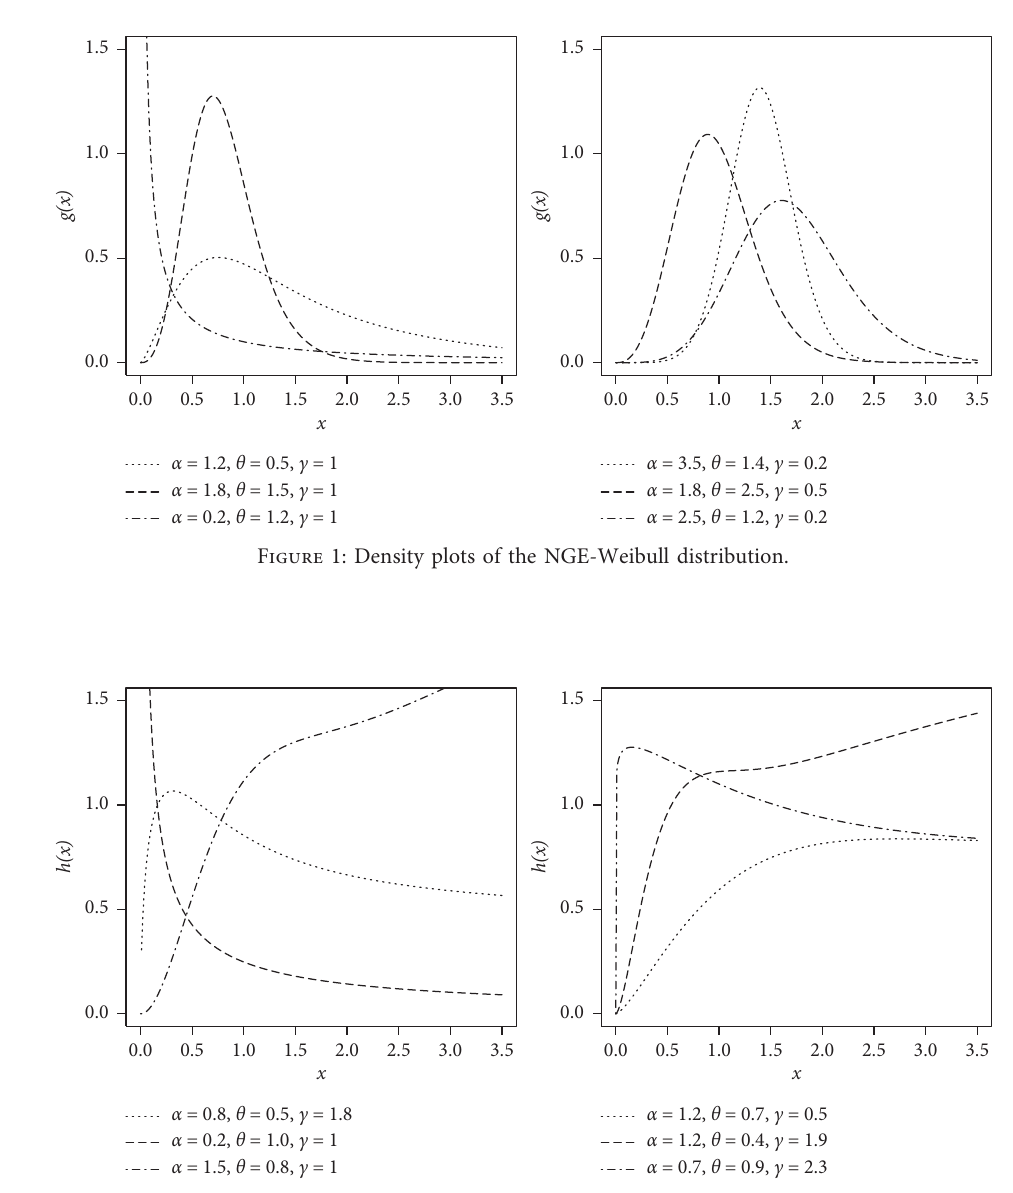
Figure 2: Hazard rate plots of the NGE-Weibull